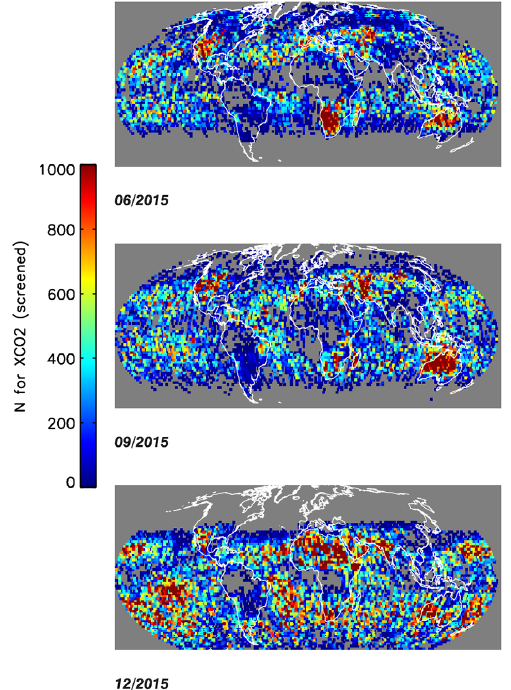
Figure 8. Maps of the number of soundings passing quality flagging for a selection of months. Statistics are provided for 2 ◦ by 2 ◦ bins for data selected with the data quality